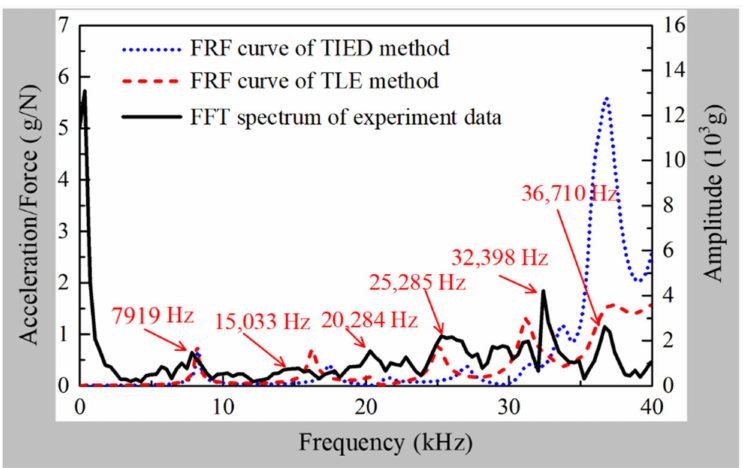
Figure 17. FRF curves of the TLE method and TIED method (source elaborated by authors). Table 10. Resonance frequencies of the TLE method, TIED method, and experiment (source elaborated by authors).